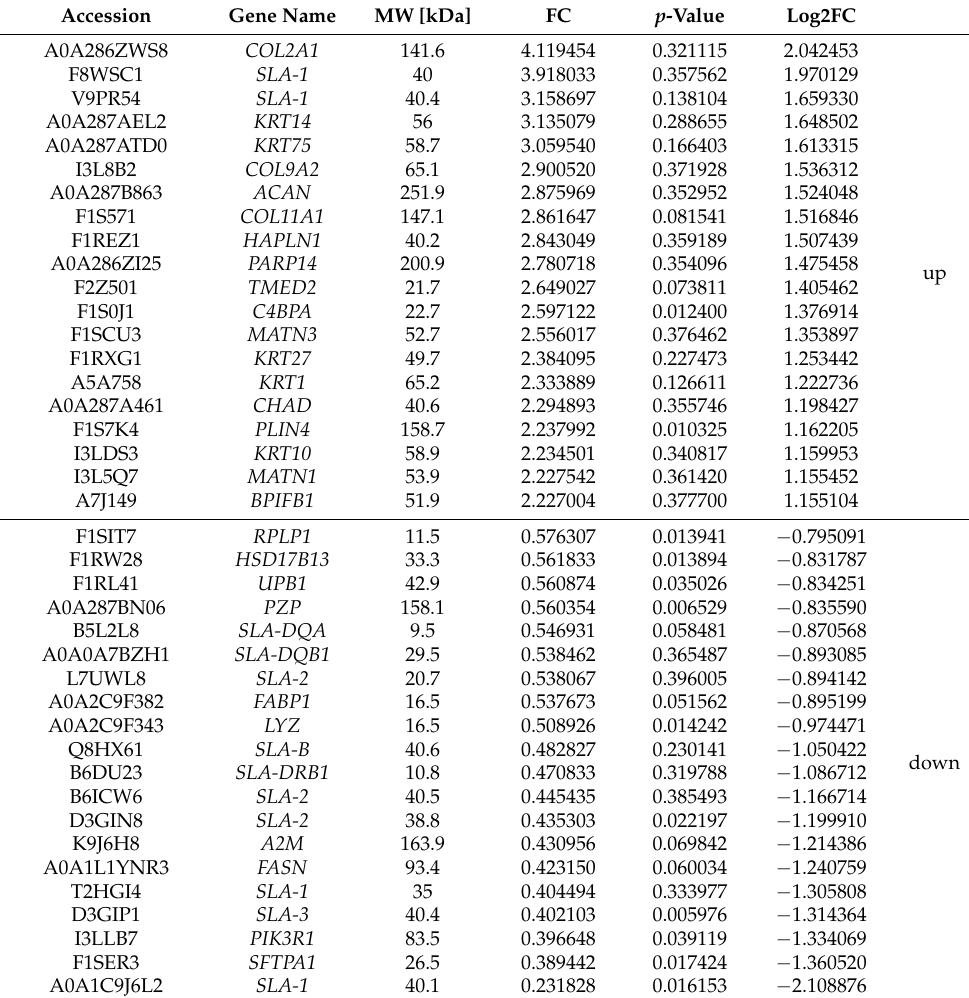
Figure 4. Cluster analysis of differentially expressed genes. Heatmap of differentially expressed proteins between two groups ( A ); distribution of identified proteins among the different molecular weight groups [in kDa] ( B ); volcano plot of differentially expressed proteins ( C ); and differentially expressed genes ( D ). Table 2. Detail information for the top 20 differentially expressed